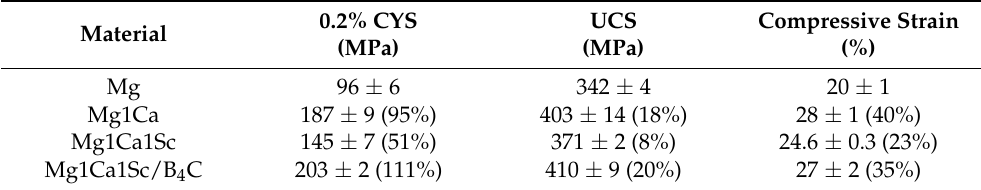
Table 2. Comparison properties between E21 and the Mg1Ca1Sc/B 4 C nanocomposite.